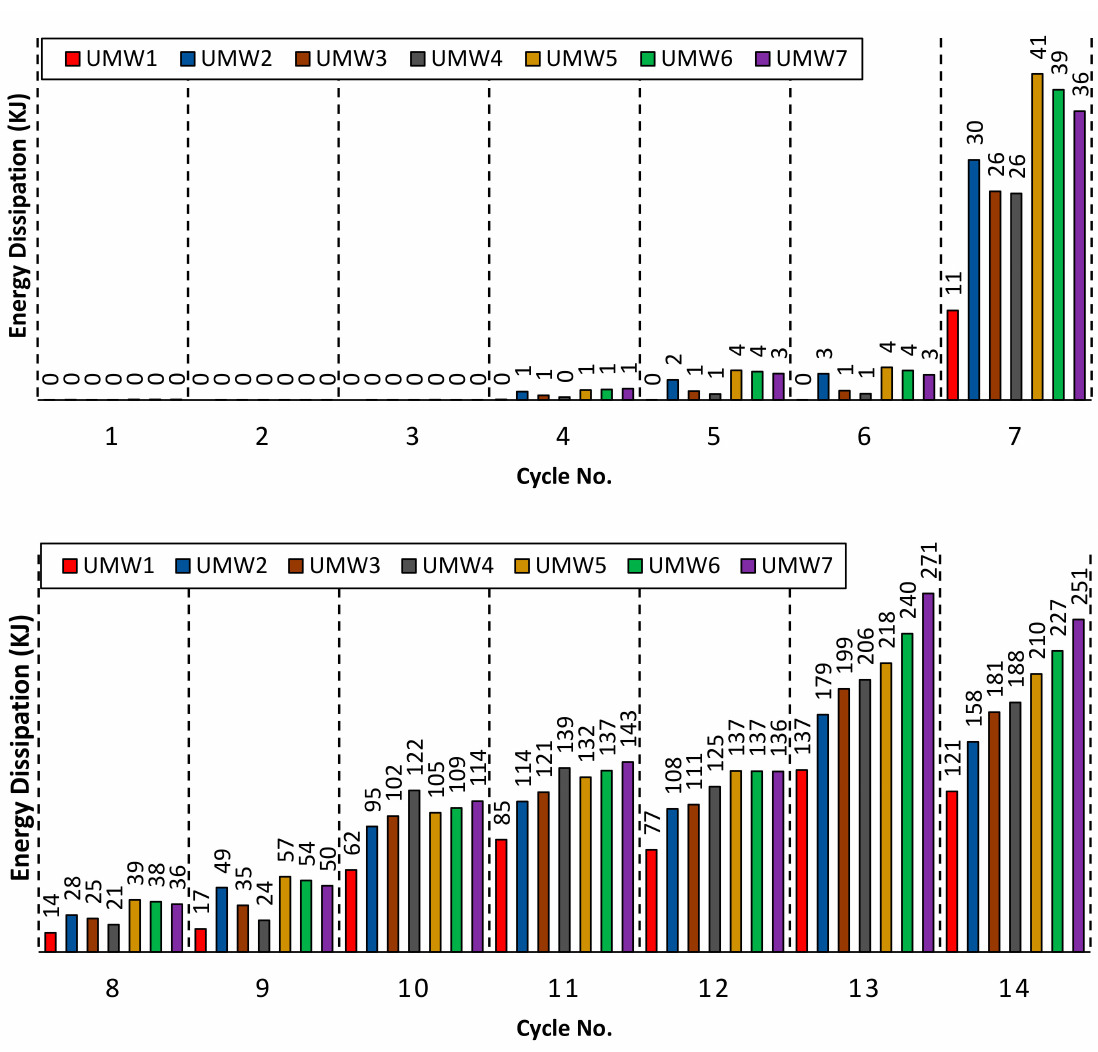
Figure 21. Energy dissipation at each load cycle.